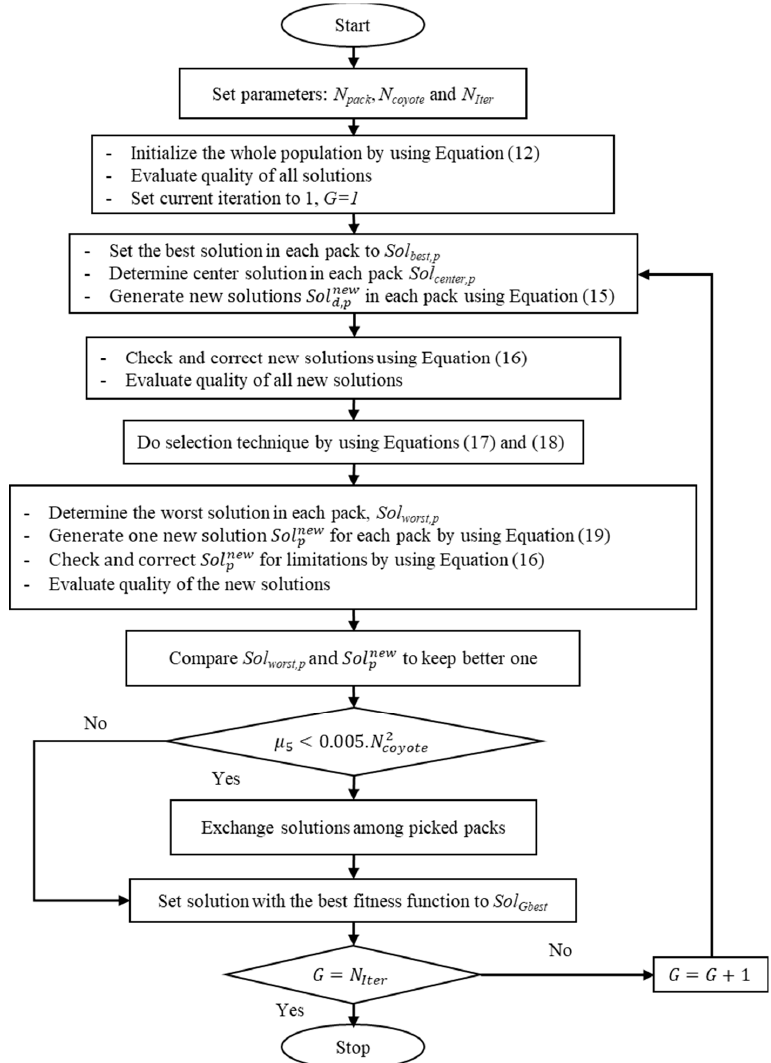
Figure 2. The flowchart of using COA for solving a typical optimization problem.